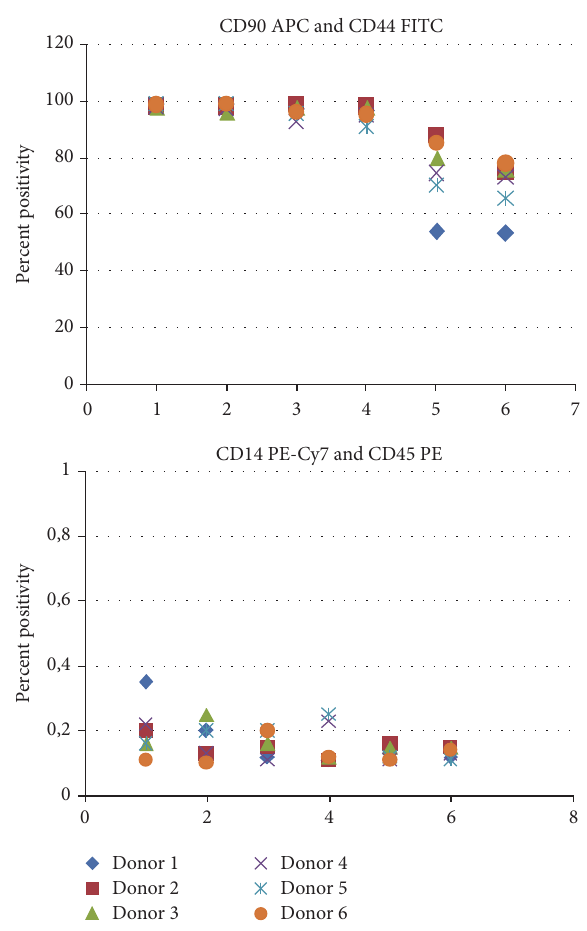
Figure 4: Flow cytometry results. Expression of cluster of differen- tiation (CD) during cultivation from passage 1 (P1) to